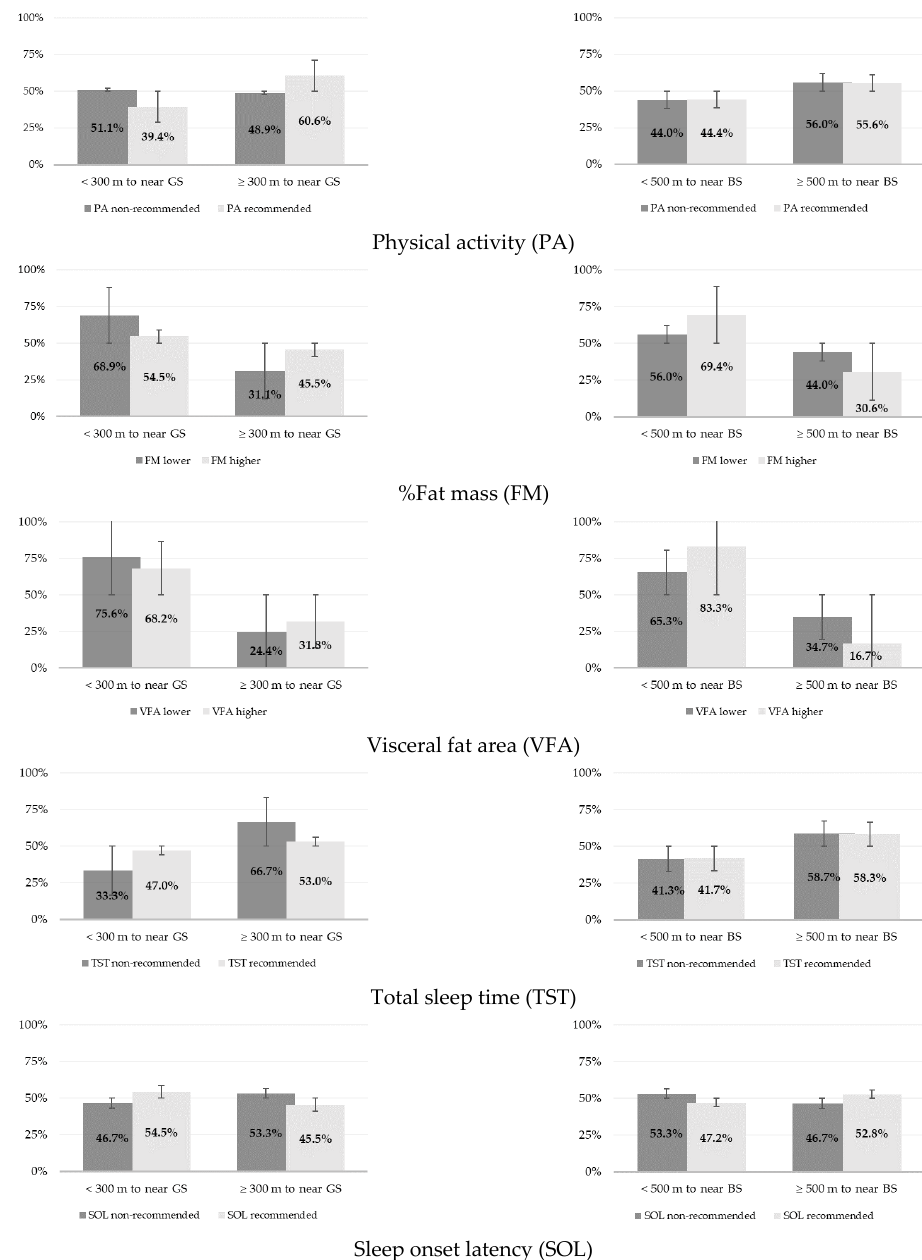
Figure 2. Classification of physical activity levels, adiposity, and sleep outcomes according to distances to green (300 m) and blue spaces (500 m); GS — green space; BS — blue space. Loss values, eigenvalues, and fit values to show the similarities among sets are pre- sented in Table 3. The eigenvalues obtained from this study were 0.427 (first dimension) and 0.403 (second dimension). The eigenvalues of the two dimensions add up to a fit of 0.830, and they can be interpreted as a proportion of explained variance. The fit shows to